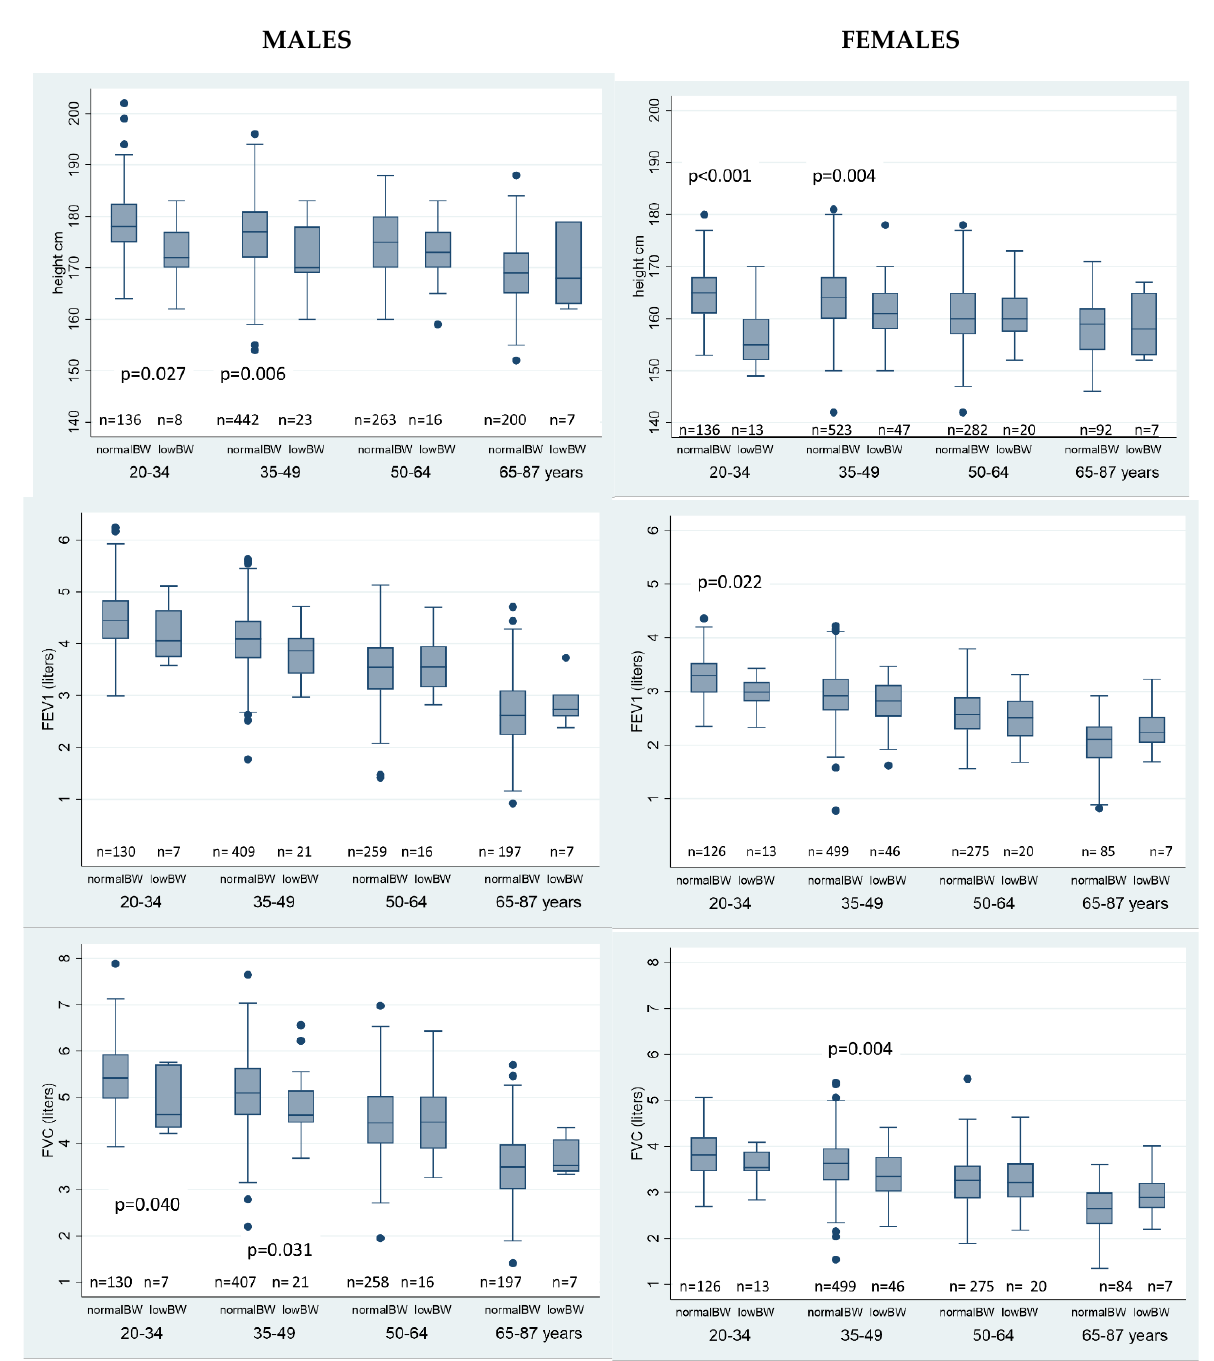
Figure 1. Differences in height, FEV1 and FVC between individuals by birthweight category as a function of sex and age. function of sex and